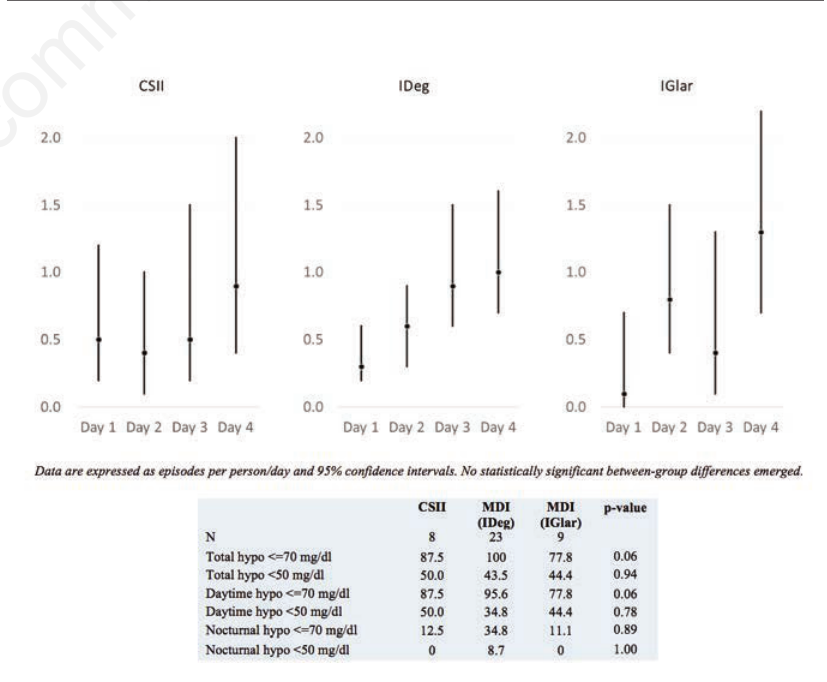
Figure 3. Hypoglycemic events during the diabetes camp by insulin regimen. A) Incidence of hypo by day during the camp. B) % of patients with at least 1 hypoglycemic episode during the